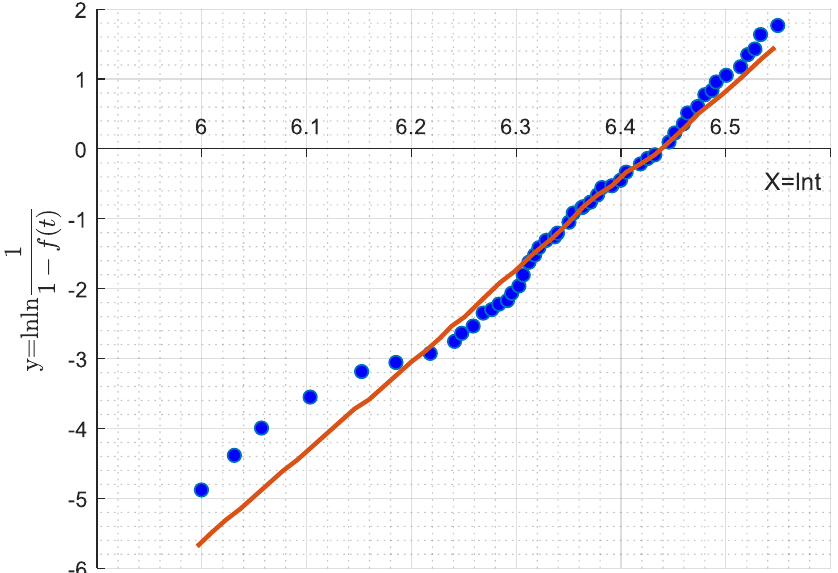
Figure 13. Linear least square estimation diagram of lithium iron phosphate battery.